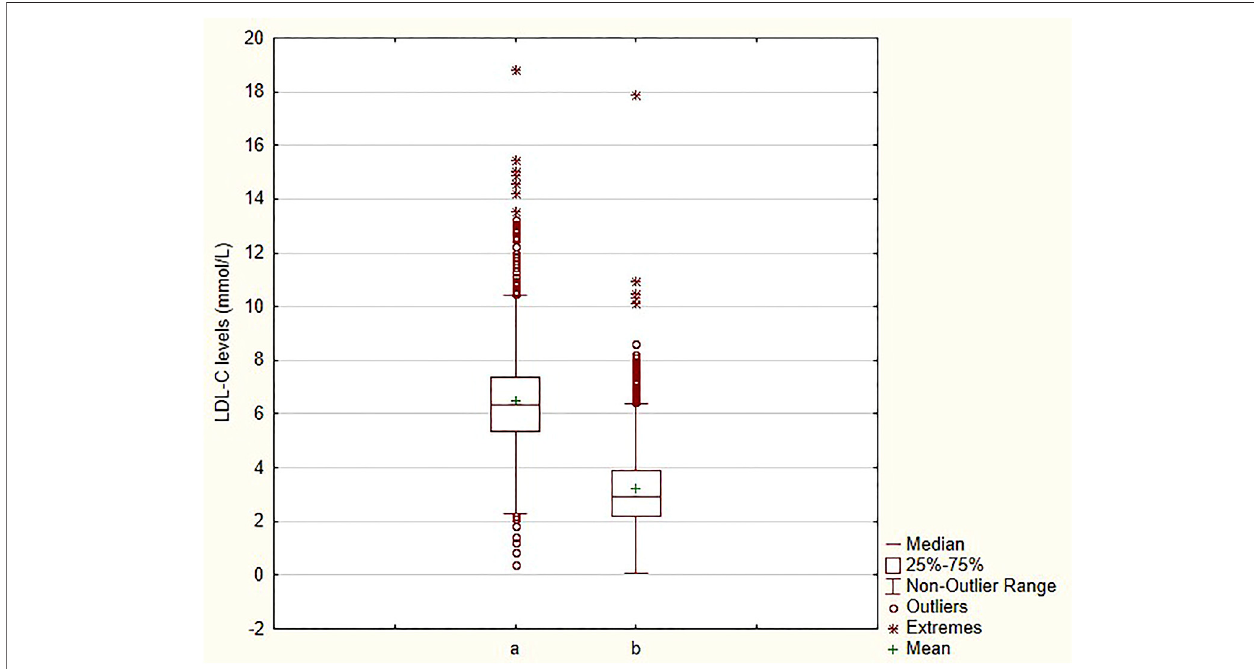
FIGURE 1 | Comparison of LDL-C levels at baseline and at follow-up a — baseline; b — follow-up; LDL-C — low-density lipoprotein cholesterol.